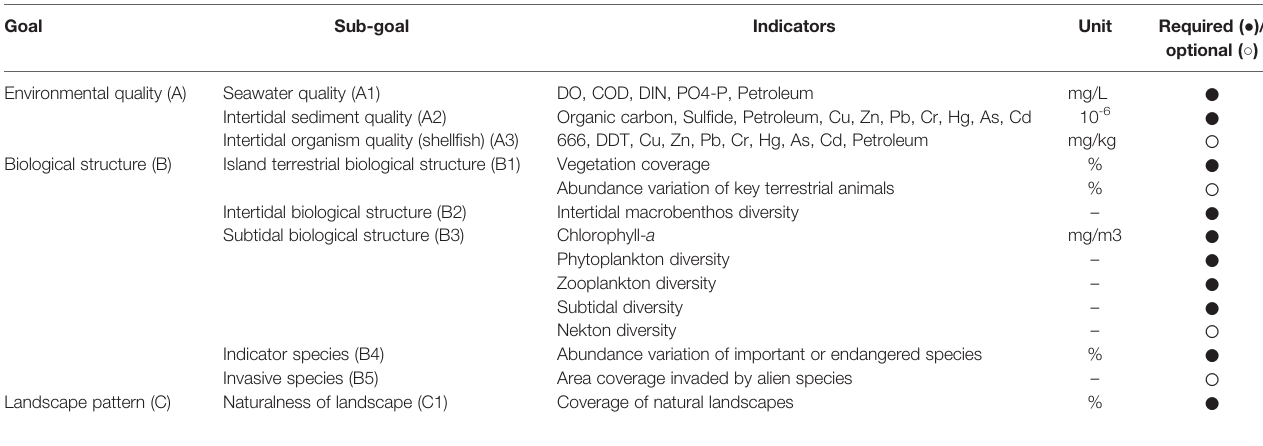
TABLE 3 | Island ecosystem assessment